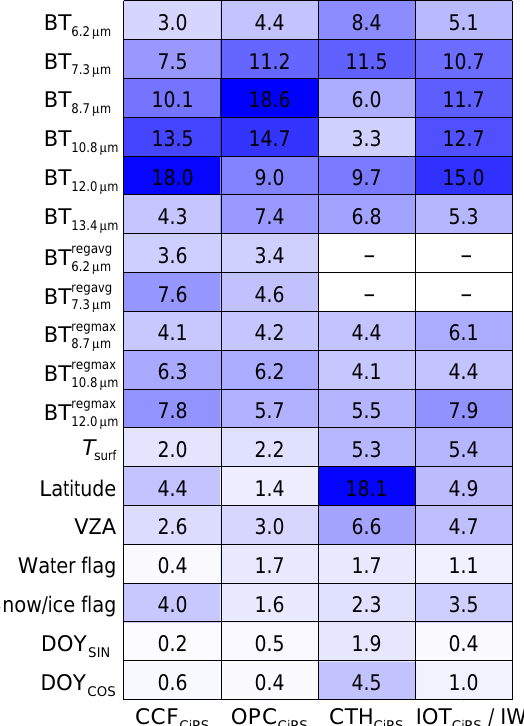
Figure 1. Relative importance of the CiPS input variables (verti- cal axis) for the four ANNs (horizontal axis). The blue shades fur- ther highlight the magnitude of the relative importance with fad- ing colours for decreasing importance. BT is brightness tempera- ture, regavg is regional average, regmax is regional maximum and VZA is viewing zenith angle. DOY SIN = sin ( 2 π DOY / 365 ) and DOY COS = cos ( 2 π DOY / 365 )